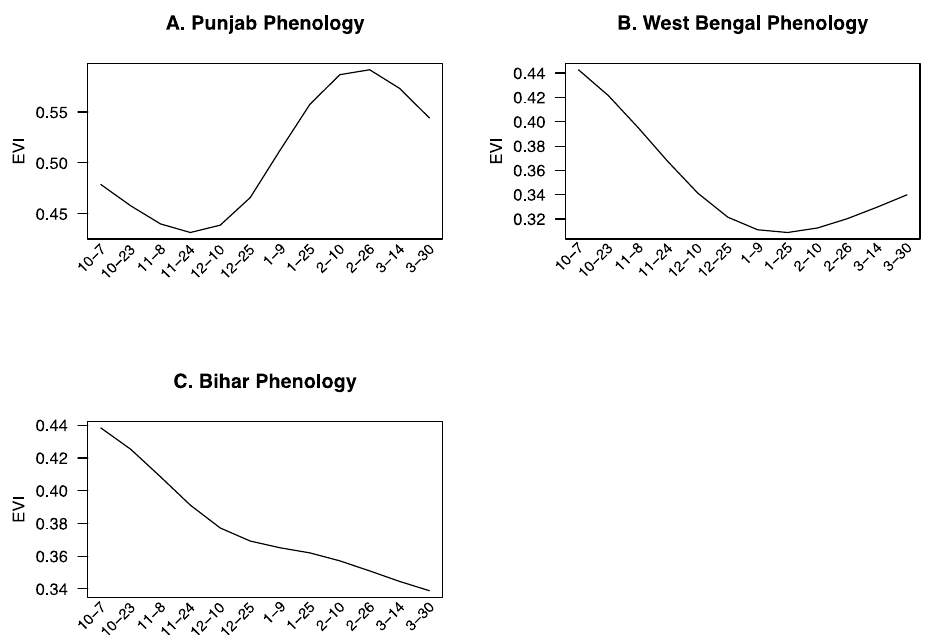
Figure 4. Examples of MODIS EVI phenology for pixels that appear to be cropped in the high-resolution imagery for Punjab ( A ); West Bengal ( B ); and Bihar ( C ). The pixel from Punjab appears as cropped in our MSA dataset but the pixels from West Bengal and Bihar do not. In West Bengal, the crop was planted during the monsoon season (e.g., July to August) according to green up dates of the phenology and reached peak greenness before or very early in the winter growing season (e.g., September to October) considered in our study. The MSA method does not detect these pixels as cropped since the crop was planted during the monsoon season and does not green up during the winter growing season window. In Bihar, the pixel is very sparsely cropped, resulting in a slight green-up that is not counted as a peak in the MODIS EVI phenology by our MSA method. This result suggests that very sparsely-cropped pixels are not detected by our MSA algorithm.